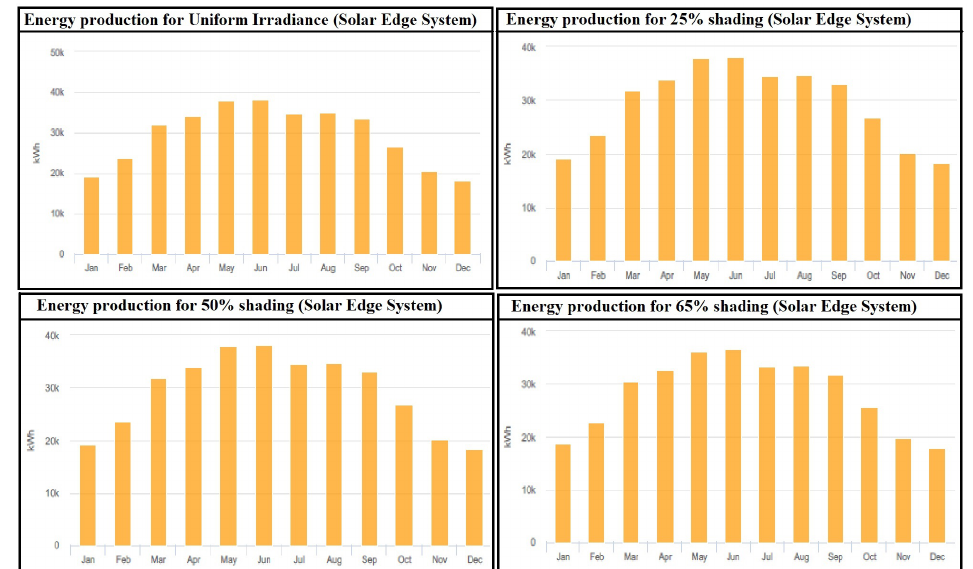
Figure 42. Results of energy production of Solar edge system on different shading conditions using